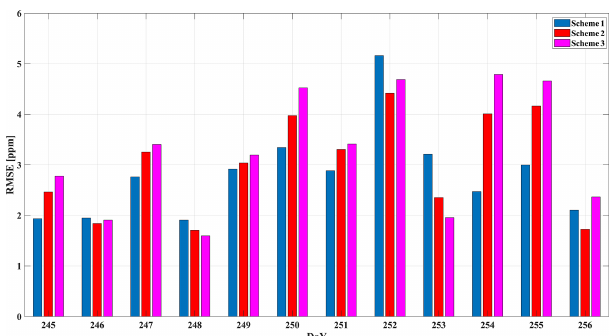
Figure 8. RMSE of wet refractivity profile for different schemes during study period at first epoch